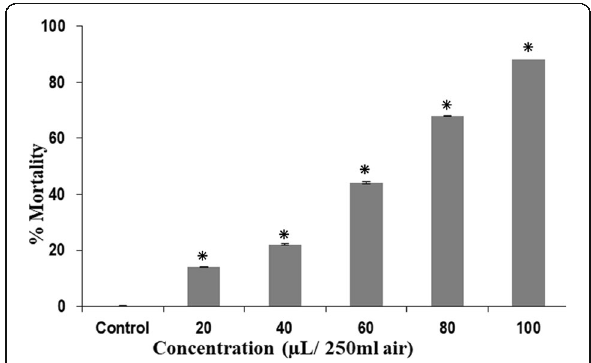
Fig. 2 Pupicidal assay showing percent (%) mortality of M. domestica larvae by fumigation method with bay EO. Significant * p < 0.001 when compared with the control. Each value represents the mean of five replicates